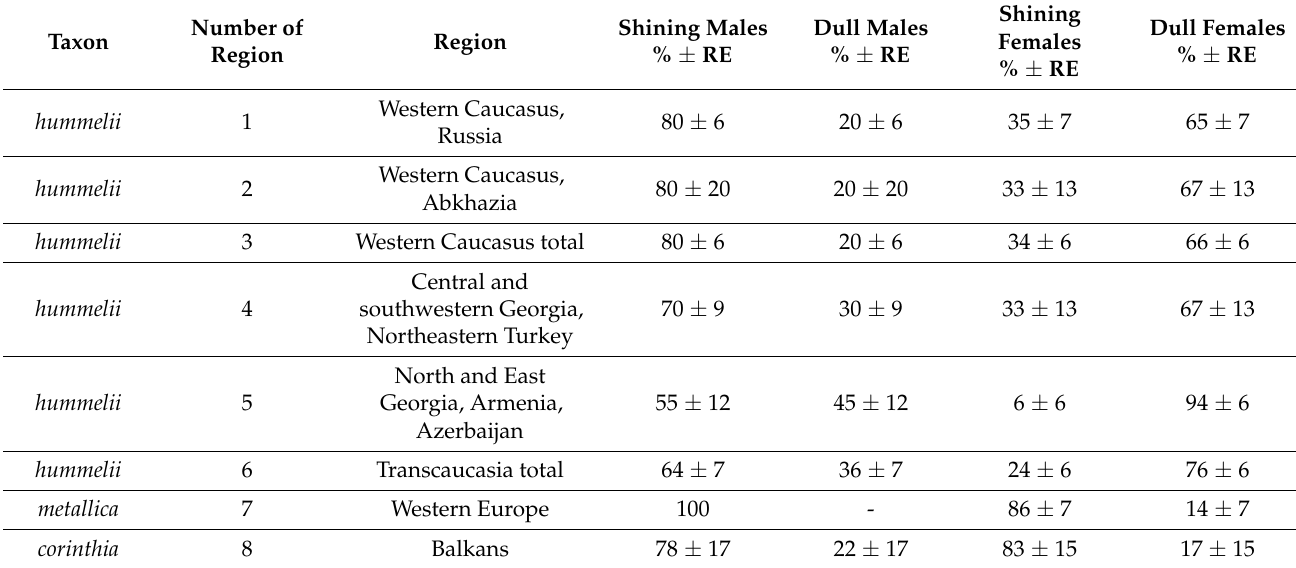
Table 13. Shine of elytron. RE—share representativeness error.